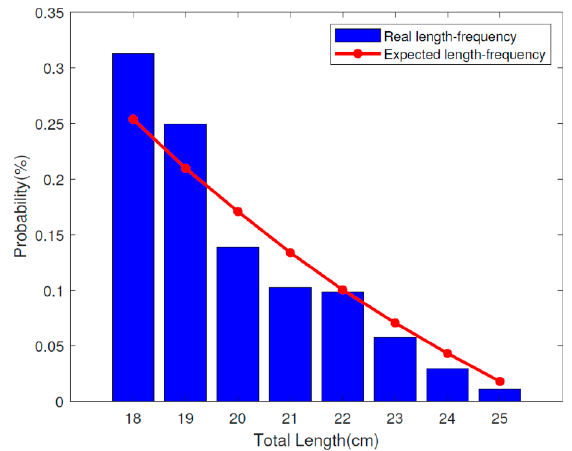
Figure 5. Modeled (redline) and observed (blue bar) length frequencies of sandfish in the eastern coastal waters of Korea from 2005 to 2008 when ∑ B i ( 0 ) = 8925 and M 0 = 2.83.